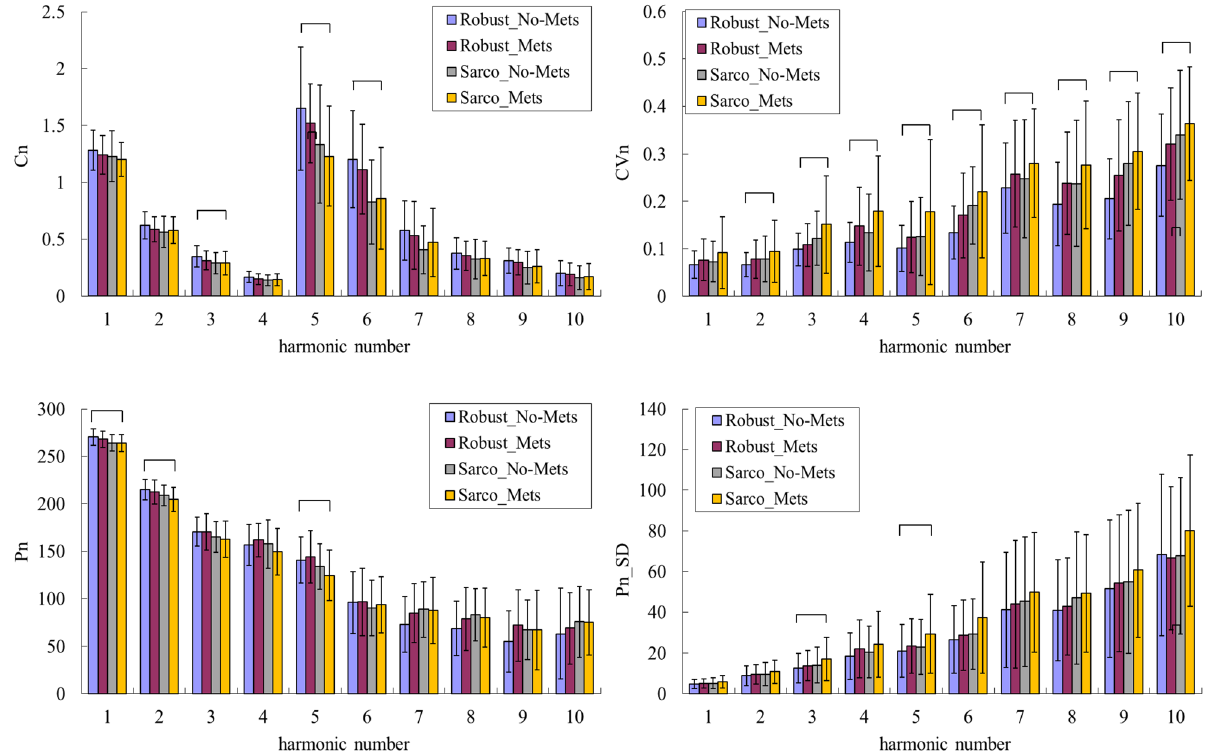
Figure 6. Comparisons of BPW harmonic indices in robust and possible-sarcopenia subjects between with and without pre-MetS: C n , CV n , P n , and P n _ SD . Data are mean and SD values. C 5 – C 10 values have been multiplied by 10 to make the differences clearer. “ (cid:6437) ” indicates p < 0.05. There were significant differences between robust + no-MetS subjects and possible-sarcopenia + pre-MetS subjects in C 5 , CV 2 – CV 10 , P 1 , P 2 , P 5 , P 3 _ SD , and P 5 _ SD ; many of these indices showed monotonically increasing or decreasing trends in the four subgroups. The differences in the pulse indices relative to the robust + no-MetS subjects were largest for possible- sarcopenia + pre-MetS